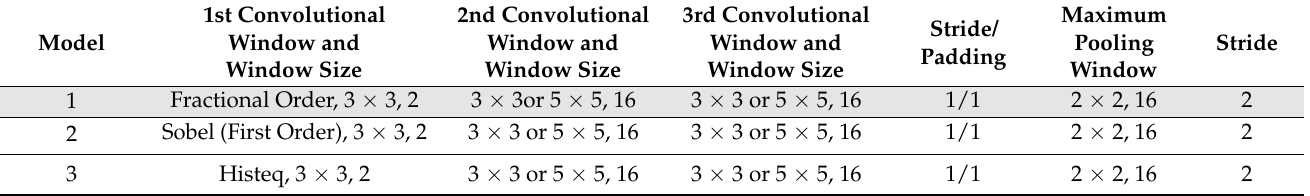
Table 5. Different convolutional layer models for feature enhancement and extraction (Models